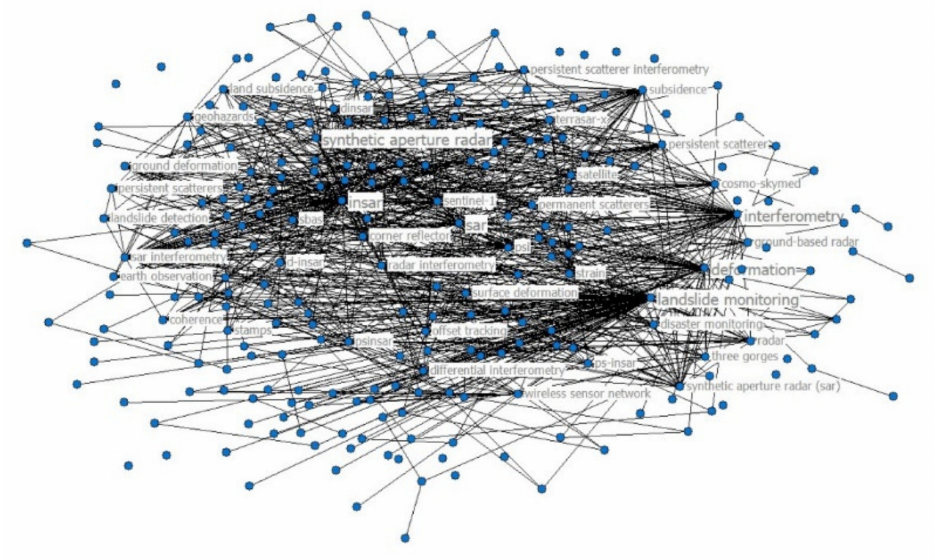
Figure 6. K-core co-occurrence network subcommunity for landslide monitoring (k ≥